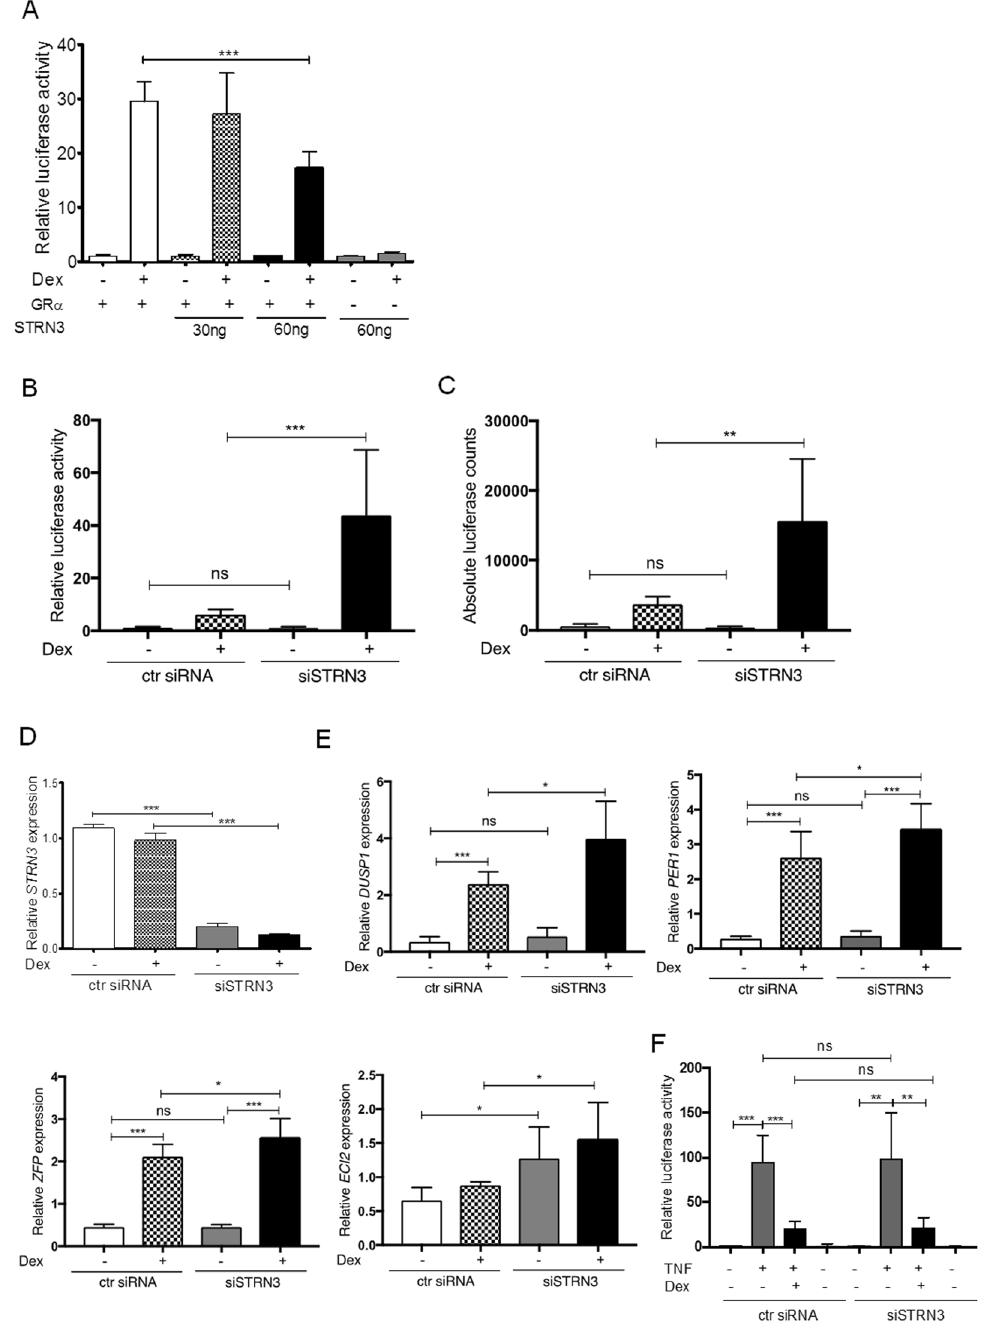
Figure 3. STRN3 is an inhibitor of GR trans-activation. ( A ) HEKT293T cells were transfected in 96-well plate with 30 ng of Flag-GR, 15 ng of GRE-luc and over-expression of STRN3, 30 ng and 60 ng, as indicated (or empty vector so that total transfected DNA is 110 ng). Cells were treated with 1 μ M Dex or vehicle, for 6 h. In the last two lanes, Flag-GR was not over-expressed. ( B ) A549 cells stably transfected with GRE-Luc reporter were transfected with 50 nM siRNA On Target plus (Dharmacon) for human STRN3. Cells were treated with 1 μ M Dex or vehicle for 24 h and processed for luciferase measurement. ( C ) Representation of the absolute luciferase values of graph in ( B ). ( D ) WT A549 cells were transfected with STRN3-specific siRNA or control siRNA (as in B and C ) and stimulated with 1 μ M Dex or vehicle for 6 h before lysis and RNA extraction. A549 cells treated as in ( B , C ) were processed for qPCR to determine the endogenous STRN3 levels and ( E ) the levels of the GR- dependent genes DUSP1, PER1, ZFP and ECI2. ( F ) A549 cells stably transfected with NF- κ B-Luc reporter are transfected with human STRN3-specific siRNA or control siRNA (as in B , C , E ). Cells are subsequently treated with vehicle or with 1000 U/ml of human TNF or pre-treated with 1000 U/ml of human TNF for 1 h followed by 1 μ M Dex for 6 h or with 1 μ M Dex alone for 6 h. All data are represented as fold change to the vehicle-treated condition. The graphs represent pooled data from three independent